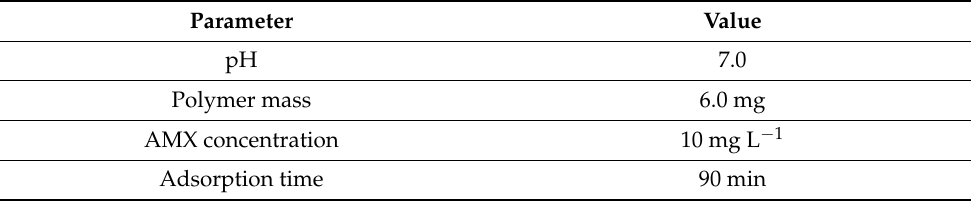
Table 3. Optimal conditions for the Amoxicillin (AMX) adsorption process.